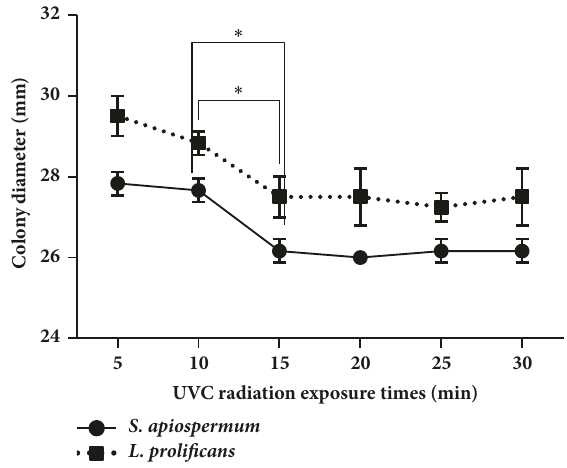
Figure 1: The UVC exposure time dependent of S. apiospermum CBS 117410 and L. prolificans